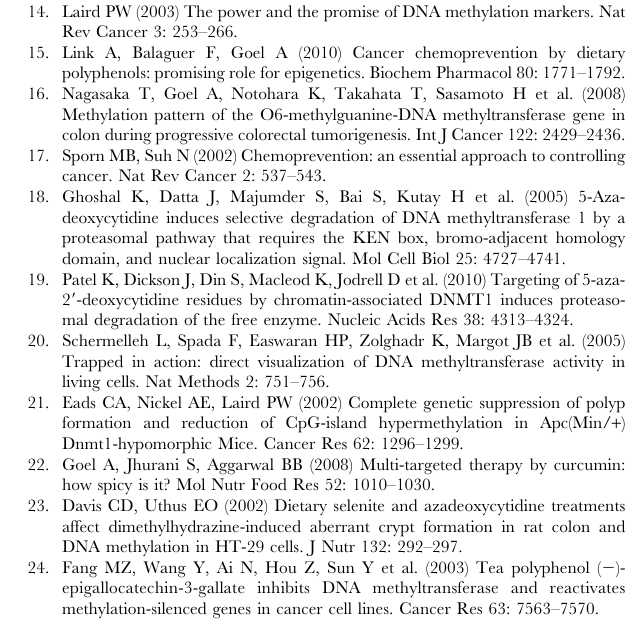
Figure S1 Ingenuity Pathway Analysis (IPA) for the microarray gene expression pattern in curcumin treated HCT116 colon cancer cells demonstrates that NFkB pathway and its downstrean genes were significant targets of curcumin-induced methylation alterations in all cell lines. Red indicates hypomethylation/up- regulated and green indicates hypermethylation/down-regulated genes. Table S1 Primer sequences for qMSP and quantitative bisulfite pyrosequencing analysis used in this